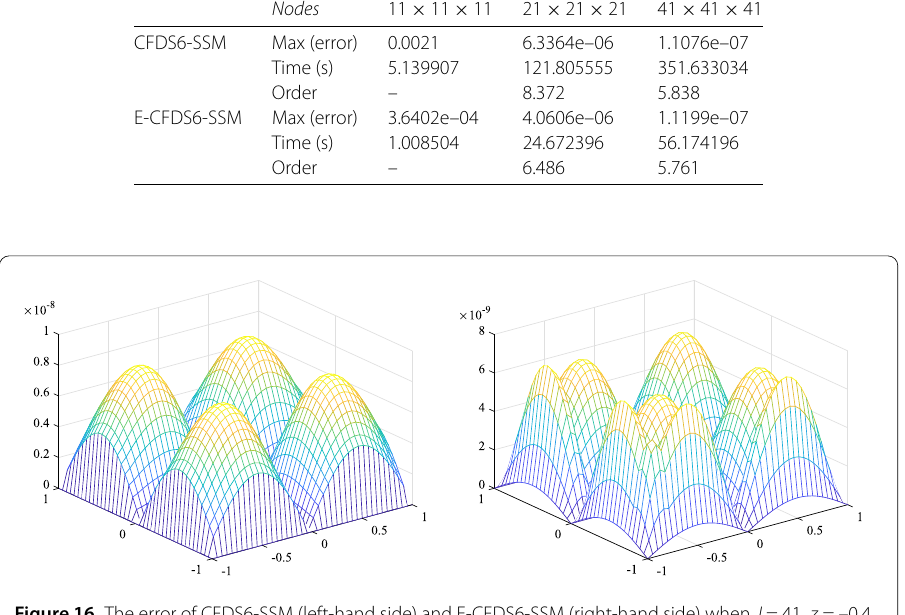
error between E-CFDS6-SSM and CFDS6-SSM is given. Besides, in Table 8, we also gave the computational time and order of convergence obtained by E-CFDS6-SSM and CFDS6- SSM, which indicates that the E-CFDS6-SSM is more efficient than the CFDS6-SSM for solving the parabolic equation and E-CFDS6-SSM holds same